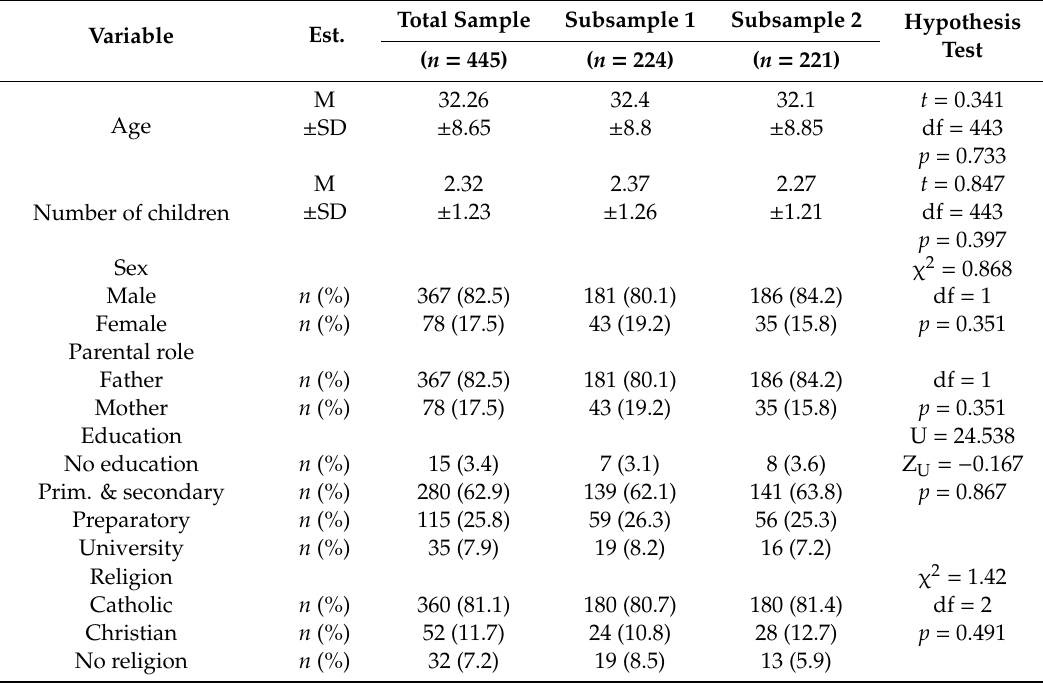
Table 1. Sociodemographic data of the family